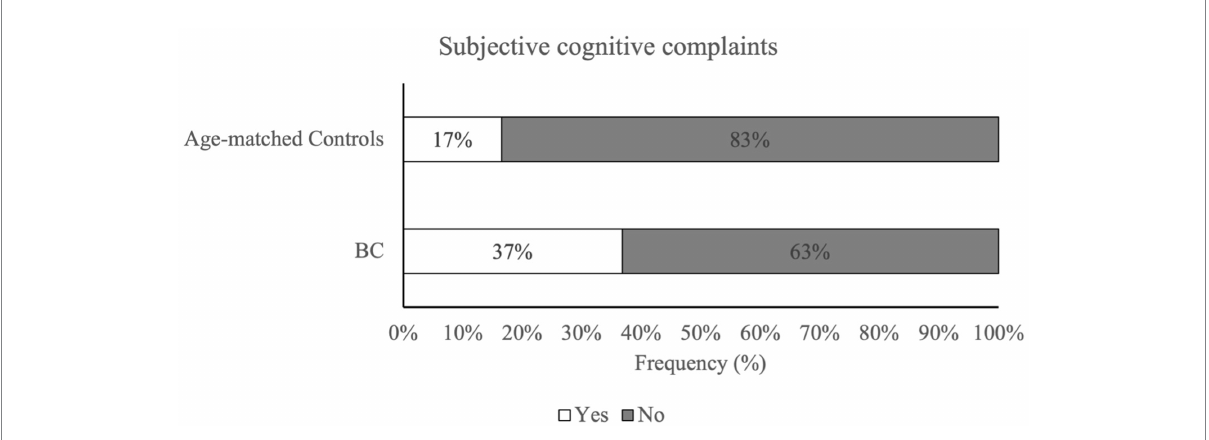
FIGURE 1 Percentage of subjective cognitive complaints in BC patients and age-matched control group. Patients with BC reported significantly higher rates of perceived cognitive difficulties when compared to age-matched controls. Subjective cognitive complaints were assessed via FACTCog – PCI18 subscale and cut-off values provided by Dyk et al. (2020).